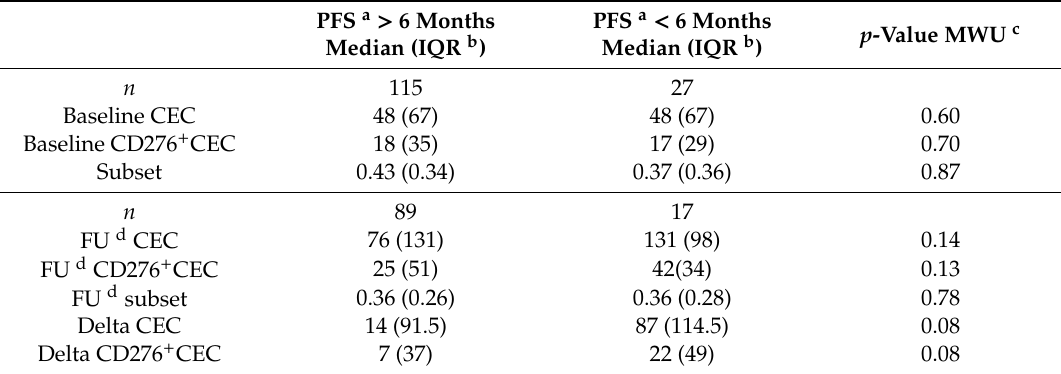
Table 2. Response prediction of (CD276 +) CEC.